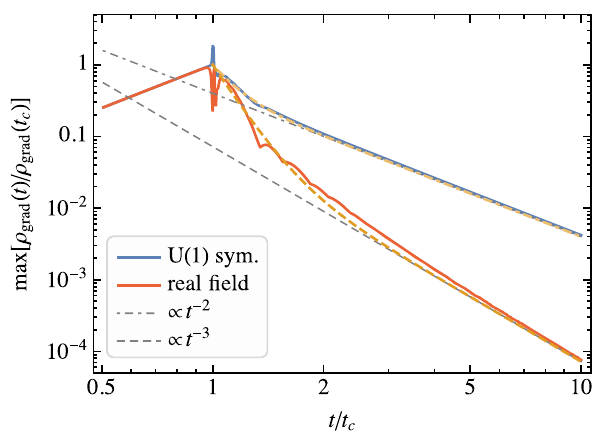
Fig. 2 Evolution of the maximal gradient energy density in a bubble collision. The blue solid line shows the average from simulations with different values of the complex phase difference between the colliding bubbles, and the red solid line shows the case where the bubbles have equal complex phase. The yellow dotdashed and dashed lines show the broken power-law approximations for the evolutions after the